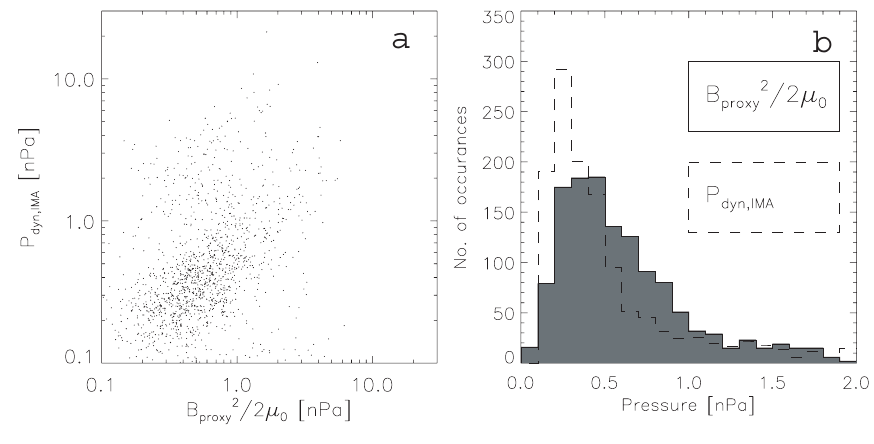
Fig. 1. (a) Measured solar wind dynamic pressure from MEX/IMA plotted vs. the MGS proxy for solar wind dynamic pressure and (b) distributions of the MGS proxy and the measured dynamic pressure from